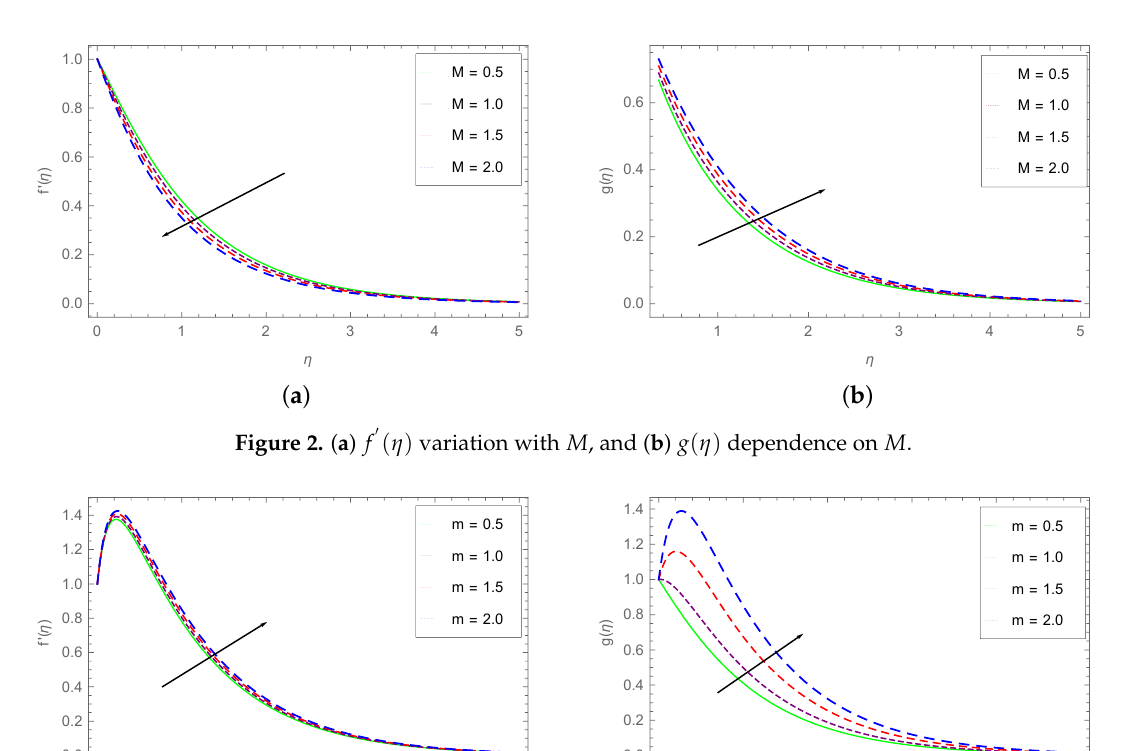
augmenting m is due to the higher Hall potentials produced in the fluid which augment the fluid velocity as well as the gradient in the velocity.